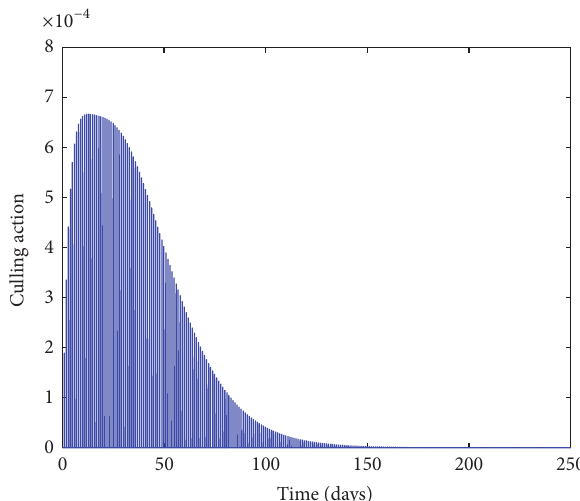
Figure 17: Evolution of the total alive population with daily culling rate of 𝜌 𝐷 = 0.1 and feedback vaccination of 𝑉 = 0.2𝑏 1 + 0.002𝑆(𝑡) .